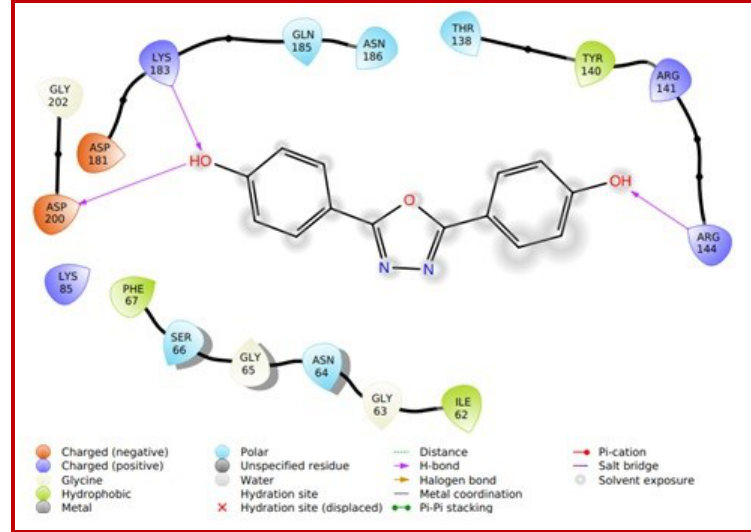
Figure 1: 2D interaction of compound 8 with